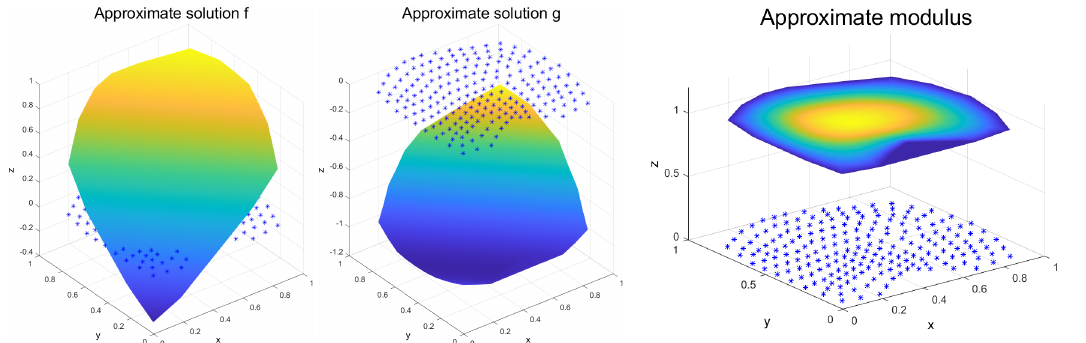
Figure 4. Approximate solutions in the Example 2.